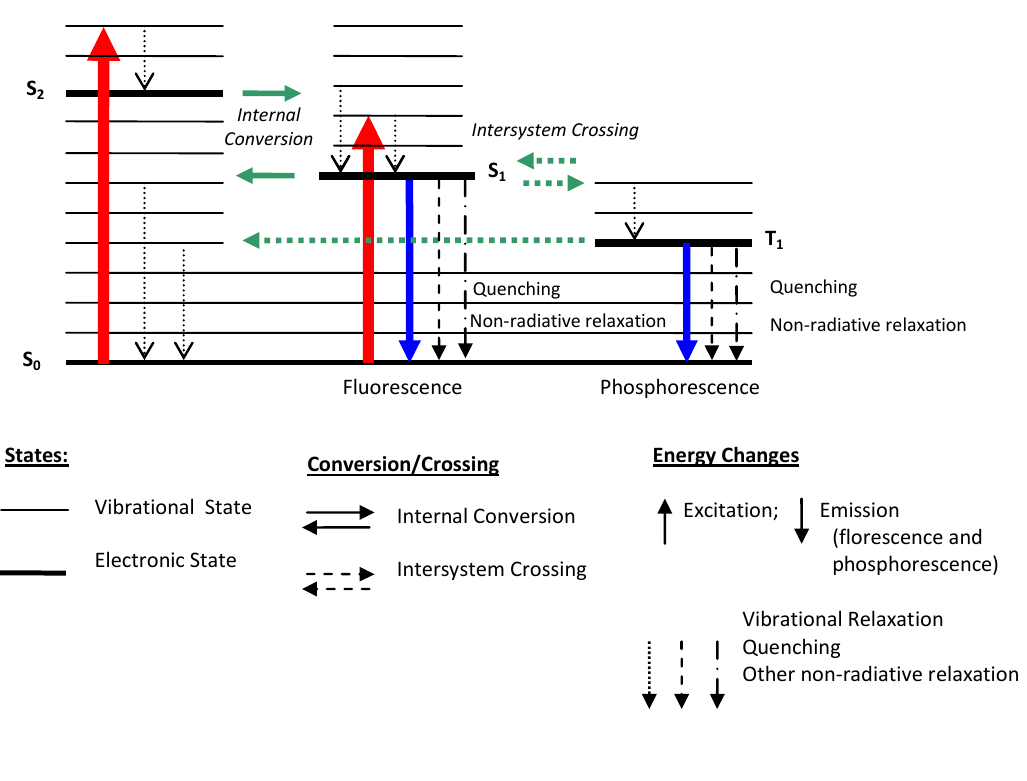
Figure 1. Jablonski energy level diagram showing the luminescence